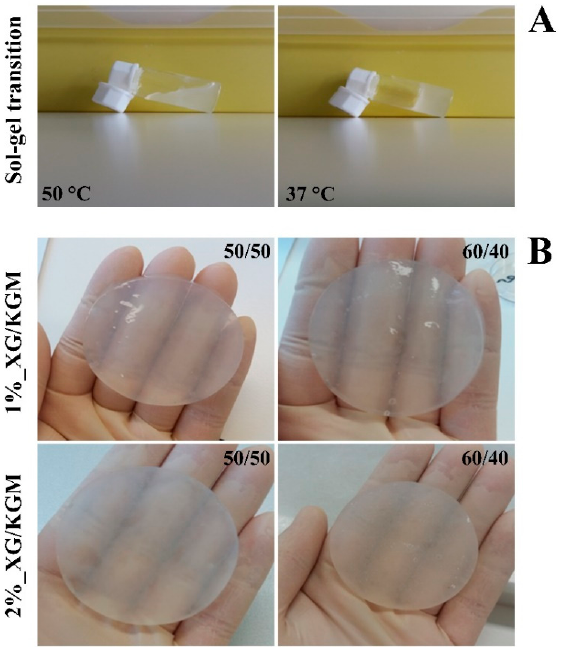
Figure1. Thesolidandthegelstatesofhydrogelsobservedatdifferenttemperatures( A )andthemacroscopic images of the hydrogels produced in this study ( B ) XG / KGM: xanthan gum–konjac